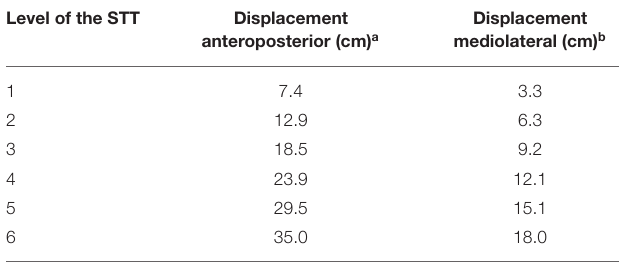
TABLE 1 | Characteristics of surface translations.